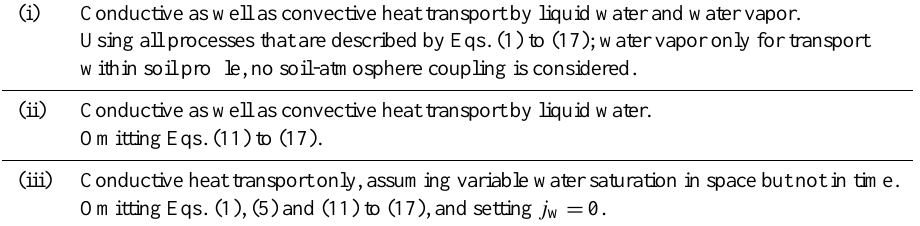
Table 2. Simulation